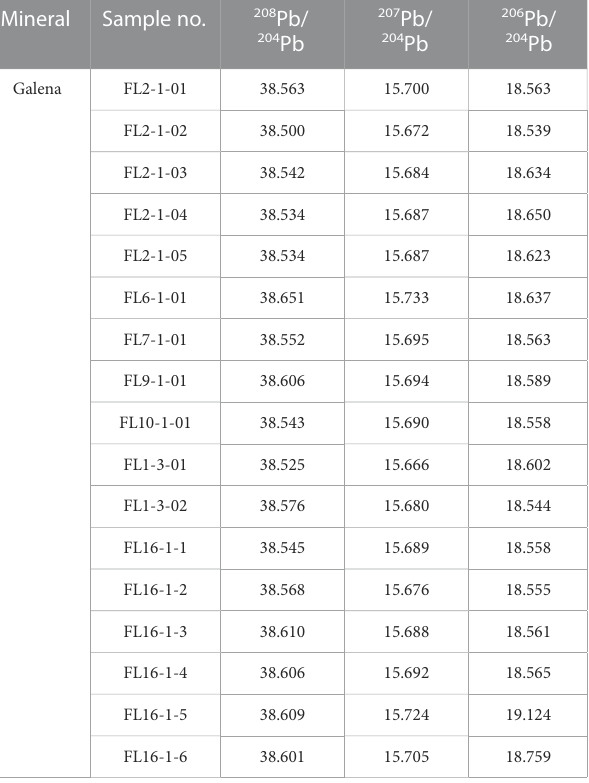
TABLE 3Summary of in situ Pb isotopic compositions inthe FuliPb-Zndeposit. Mineral Sample